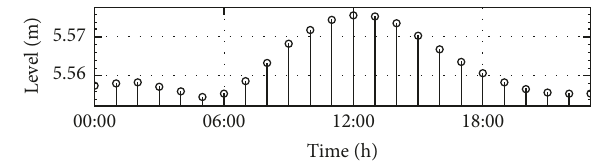
Figure 6: Directional clustering results of outlier data-contained information flows under MOC algorithm.